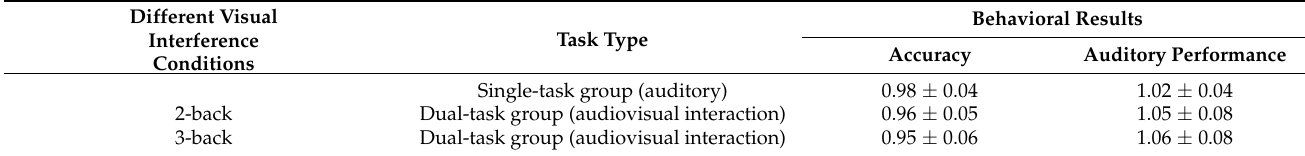
Table 4. Behavioral performance parameters in the single-task group (auditory) and dual-task group (audiovisual interaction) were statistically analyzed (mean ± standard deviation).